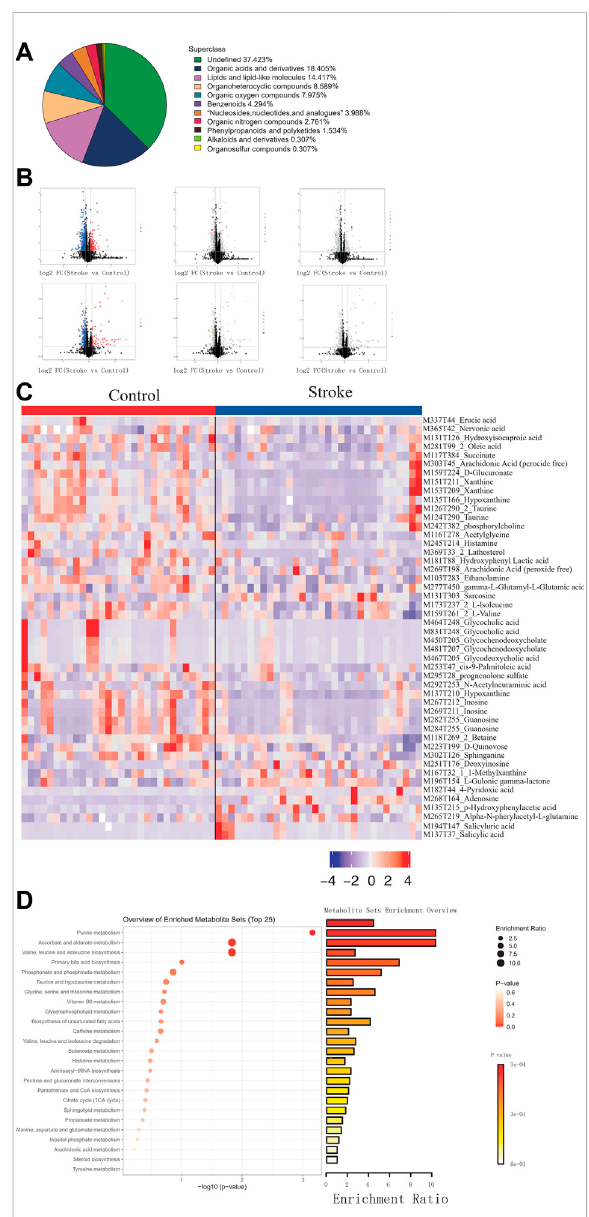
Identi fi cation of differential metabolites and dysregulated metabolic pathways in stroke patients. (A) . Proportion of the identi fi ed metabolites in each chemical classi fi cation. (B) . Volcano plot depicting differences in metabolites between stroke patients and controls. (C) . Heatmap depicting the abundance of differential metabolites in stroke patients and controls. (D) . Bubble-bar graph depicting the metabolic pathways associated with different metabolites. (E) . KEGG metabolic network diagram. (F) . Interaction network of differential metabolites (squares) and differentiallyexpressedgenes(circles). (G) . KEGGglobal metabolic network highlighting the pathways possessing signi fi cant enrichment scores. (H) . Pathway map diagram depicting depression-speci fi c dysregulated genes (in green), genes common to stroke and depression (in red), depression-speci fi c abnormal metabolites (in blue), and abnormal metabolites common to stroke and depression (in